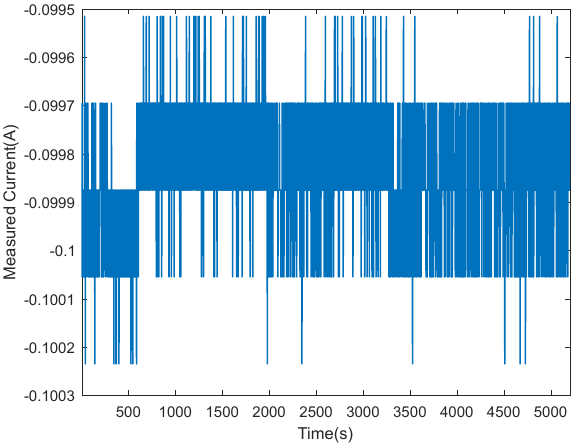
Figure 10. Relative error during low-current discharging.